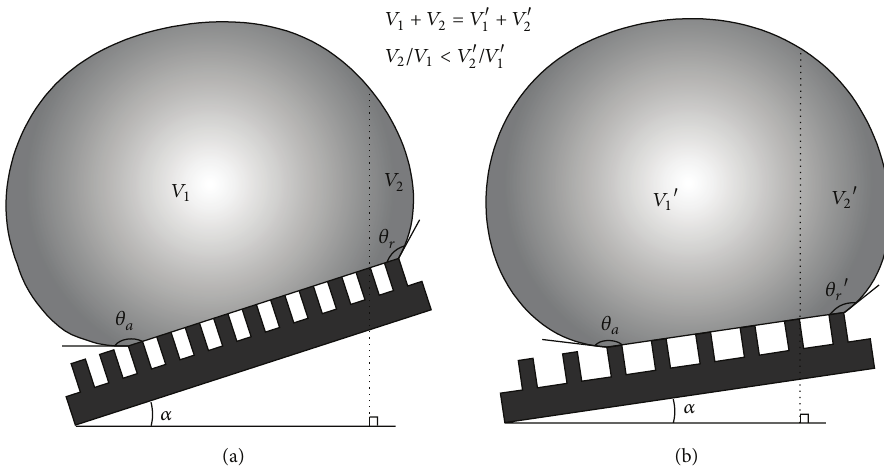
Figure 9: A droplet on inclined surfaces of different area